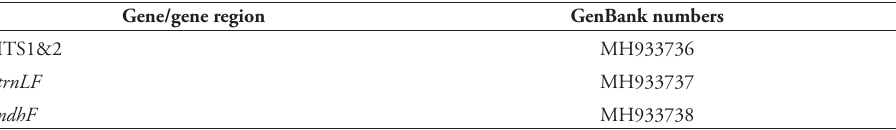
Table 2. Voucher information and GenBank numbers for Vernonia incana Less. Voucher: Paraguay, Cen- tral: Estero del Ypoa, Villeta - Puerto Guyrati, 11 km S of Villeta, east of trail to Villa Oliva. Inundated savannah on clay soil with patches of forest, Zardini & Aquino 4305, 16 Dec 1992, housed at US [US Catalog No.: 3299682; Barcode: 01627756]. Available on line at https://collections.nmnh.si.edu/search/ botany/ [search on collecting